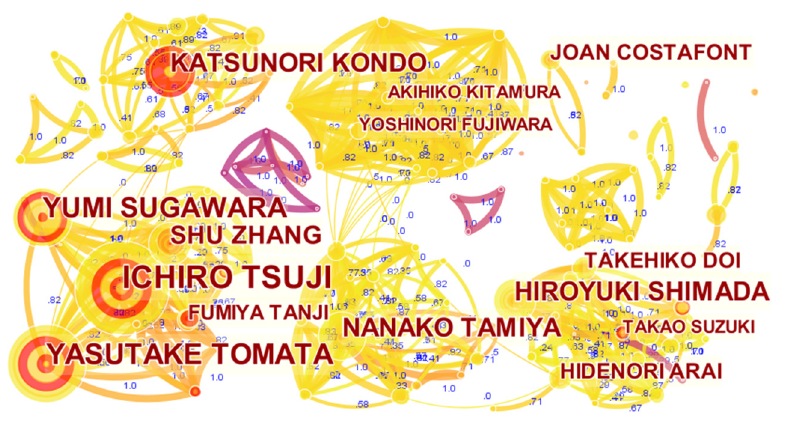
Figure 5. A visualization of the author collaboration network.